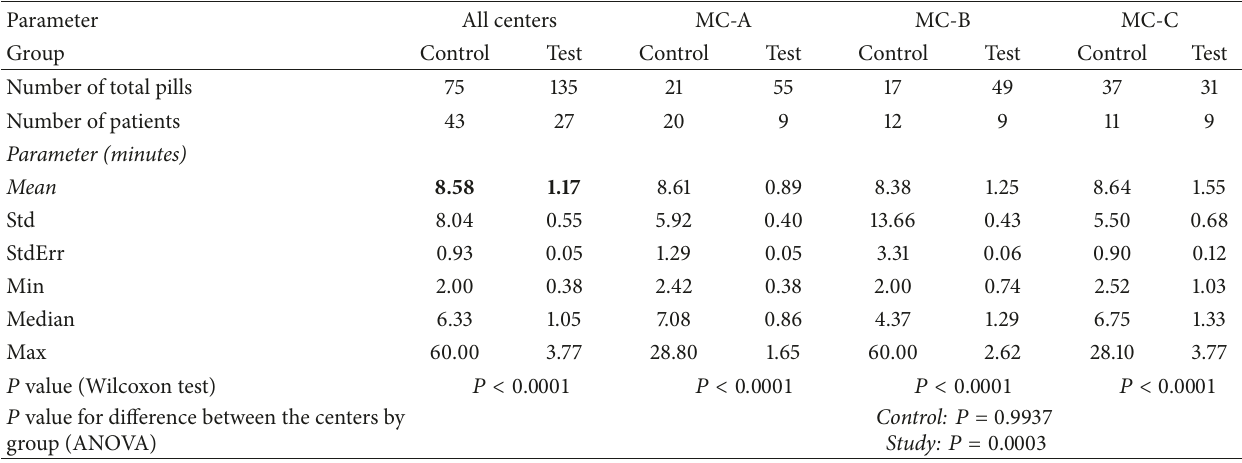
Table 3: Analysis of pill intake time (minutes) by group and by medical center. Analysis was done by nonparametric Wilcoxon- Mann–Whitney method. Analysis of variance (ANOVA) was applied for analyzing the difference in the study outcomes between study centers within study groups (MC: Medical Center).